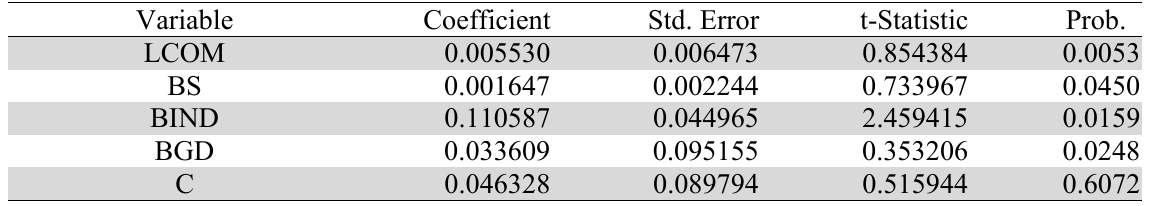
The results of the regression model